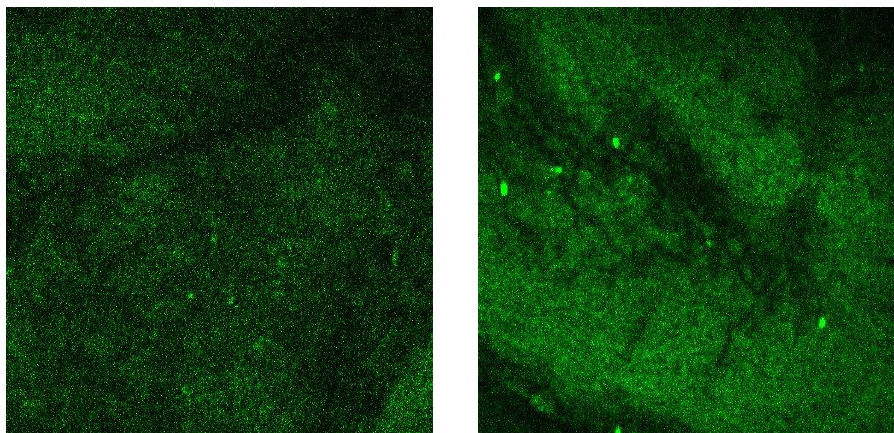
Figure 10. Superficial images made using a 2p-fluorescence microscope of skin sample ( left ) before Ir@SiO 2 NPs exposure and ( right ) after 24 h of exposure. Image size is 500 µm 500 µm.